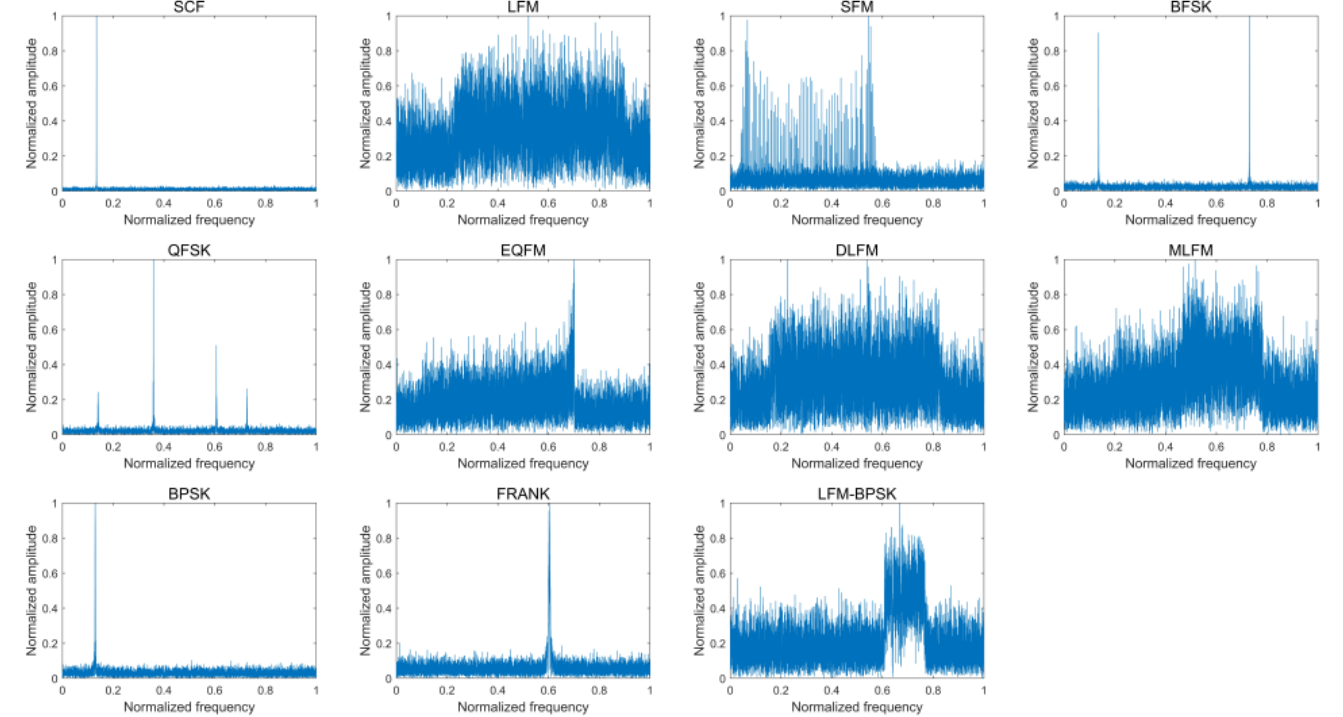
Figure 4. The frequency-domain amplitude spectra of eleven intra-pulse modulations of some radar emitter signal samples without noise ( upper ) and the according frequency-domain amplitude spectra when SNR is 0 dB ( lower